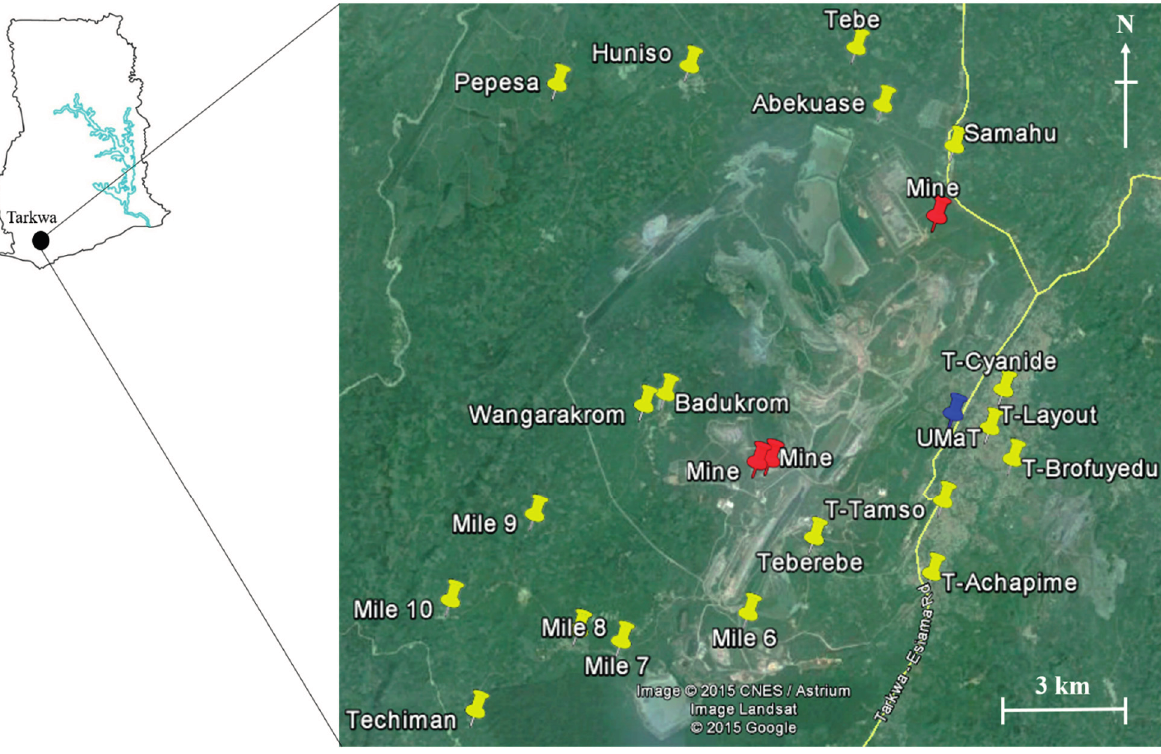
Figure 1. Map showing surface soil sampling locations in Tarkwa, Ghana (yellow, red and blue pins indicate sampled communities, gold mines and reference site (UMaT),